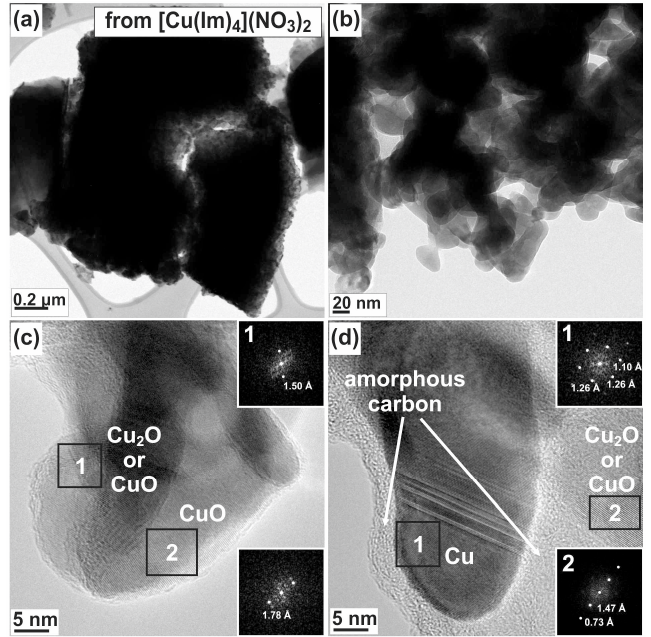
Figure 4. TEM data for solid products obtained by combustion of [Cu(C 3 H 4 N 2 ) 4 ](NO 3 ) 2 complex un- der air: ( a , b ) morphology and ( c , d ) fast Fourier transform (FFT) patterns are calculated from the TEM image of individual particles.